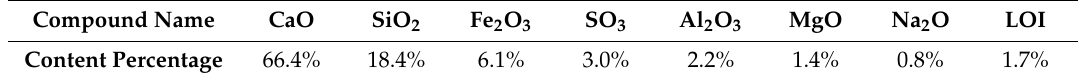
Table 1. Chemical composition of Portland